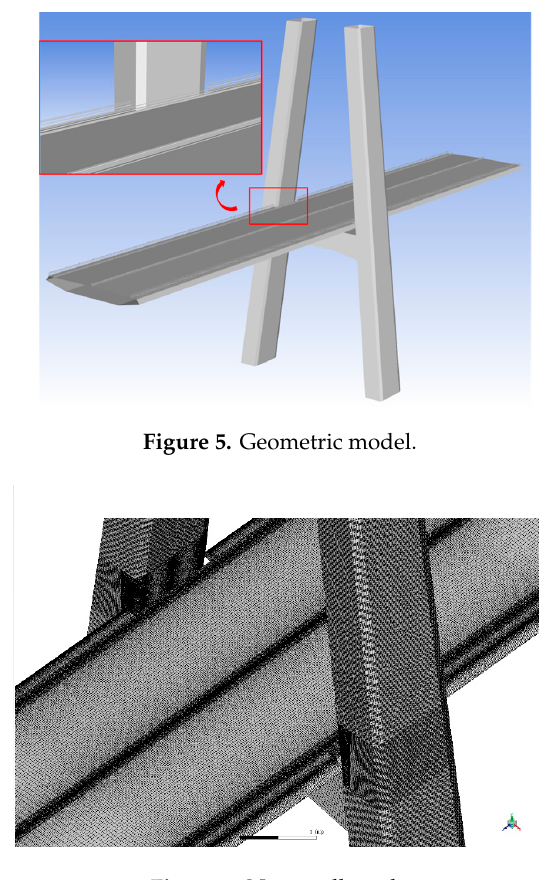
Figure 5. Geometric model. Figure 6. Near wall mesh.